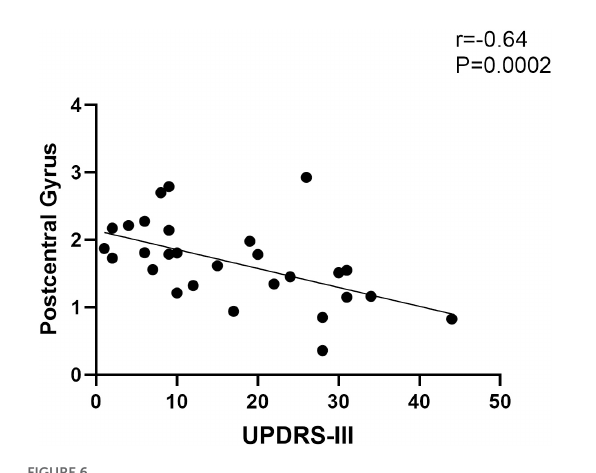
FIGURE6 Functional connectivity of the post-central gyrus within the sensorimotor network in EOPD is negatively correlated with UPDRS-III scores (Spearman correlation; P < 0.05/3, Bonferroni